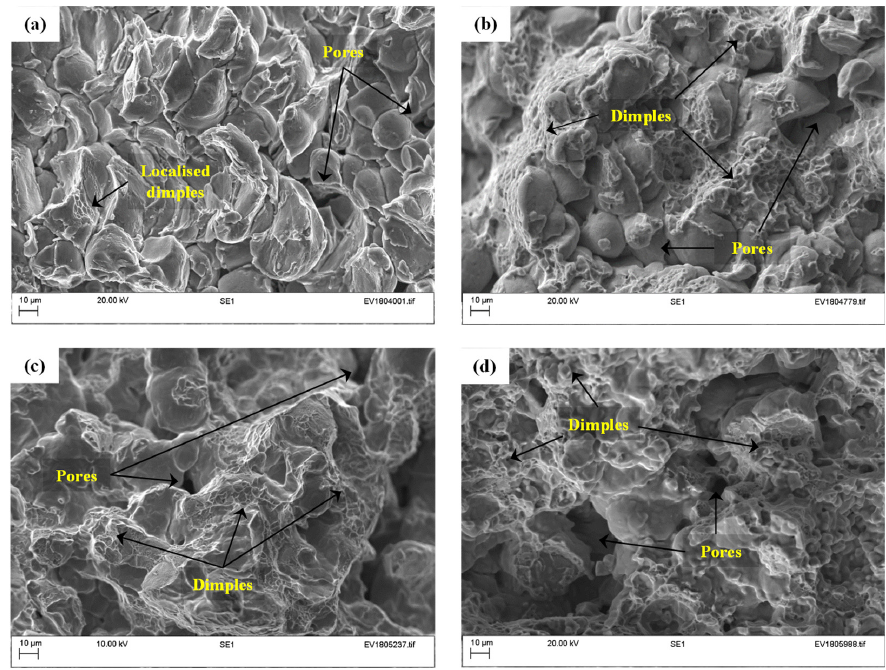
Figure 5. SEM images of fracture surfaces of fully CS tensile specimens in four different conditions: